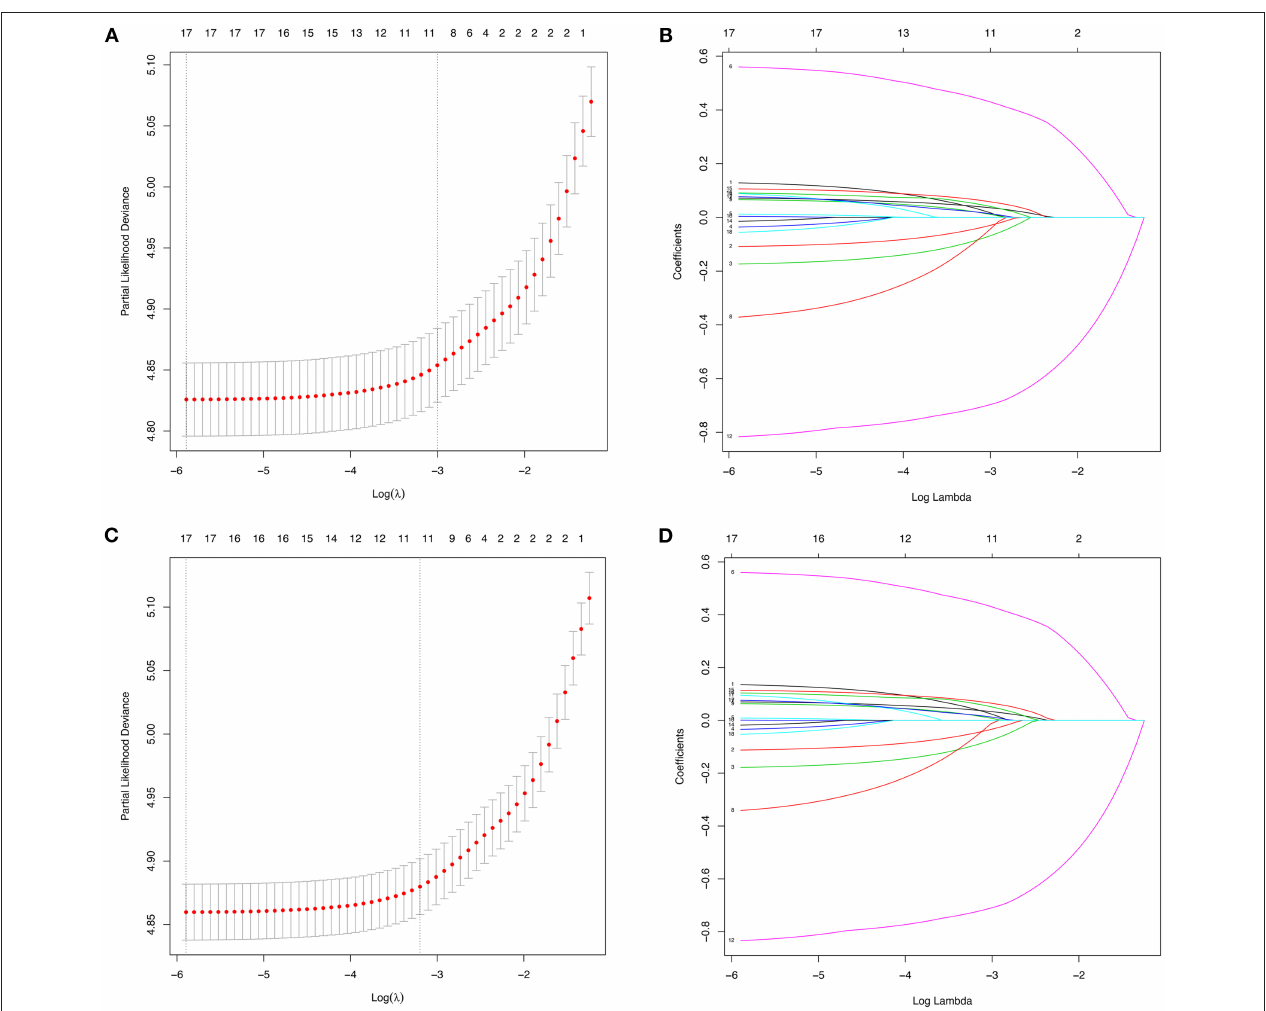
FIGURE 2 | The identification of predictive prognostic factors for overall survival (OS) (A,B) and lung cancer-specific survival (CSS) (C,D) in the training cohorts of patients with N3-NSCLC by the least absolute shrinkage and selection operator (LASSO) regression.